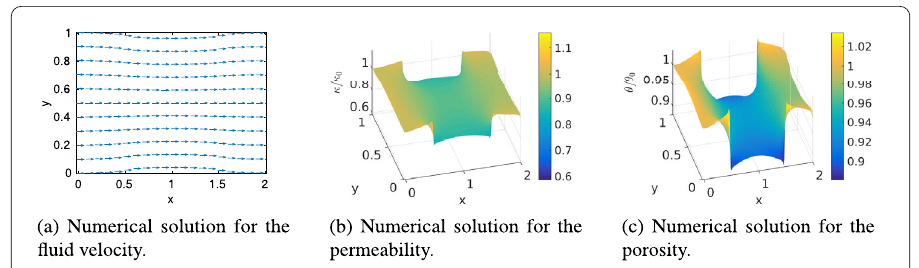
Figure 17 Numerical solutions for the fluid velocity, the permeability and the porosity, at time t = 300, obtained using the network-inspired relation with p c = 0.3232